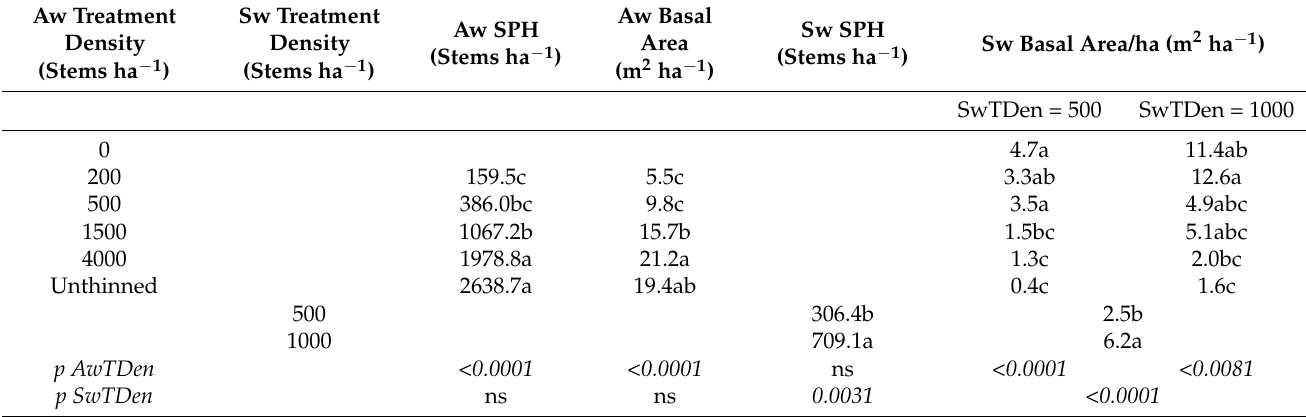
Table 2. Effects of thinning treatments applied at age 5 on stand densities (SPH, expressed in terms of stems ha − 1 ) and stand basal area (expressed as m 2 ha − 1 ) of the two primary species at age 26. For aspen (Aw) treatment density (AwTDen) and spruce (Sw) treatment density (SwTDen) means followed by different letters were found to differ significantly ( α = 0.05) based on Tukey’s HSD